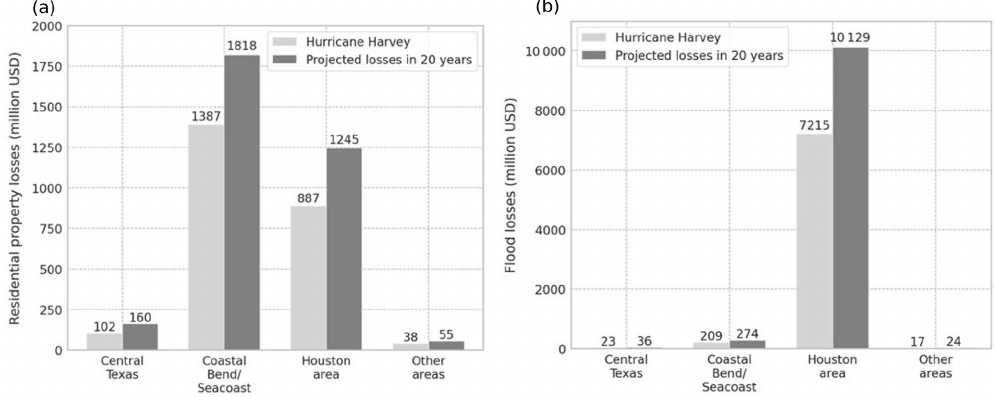
Figure 12. (a) Estimated residential property loss due to hurricane impact across the Hurricane Harvey-affected region over a 20-year period, assuming constant dollars. (b) Estimated flood loss due to hurricane impact across the Hurricane Harvey-affected region over a 20- year period, assuming constant dollars. These values are calculated by multiplying the loss values from Hurricane Harvey in each subregion by the expected 20-year housing growth rate for each